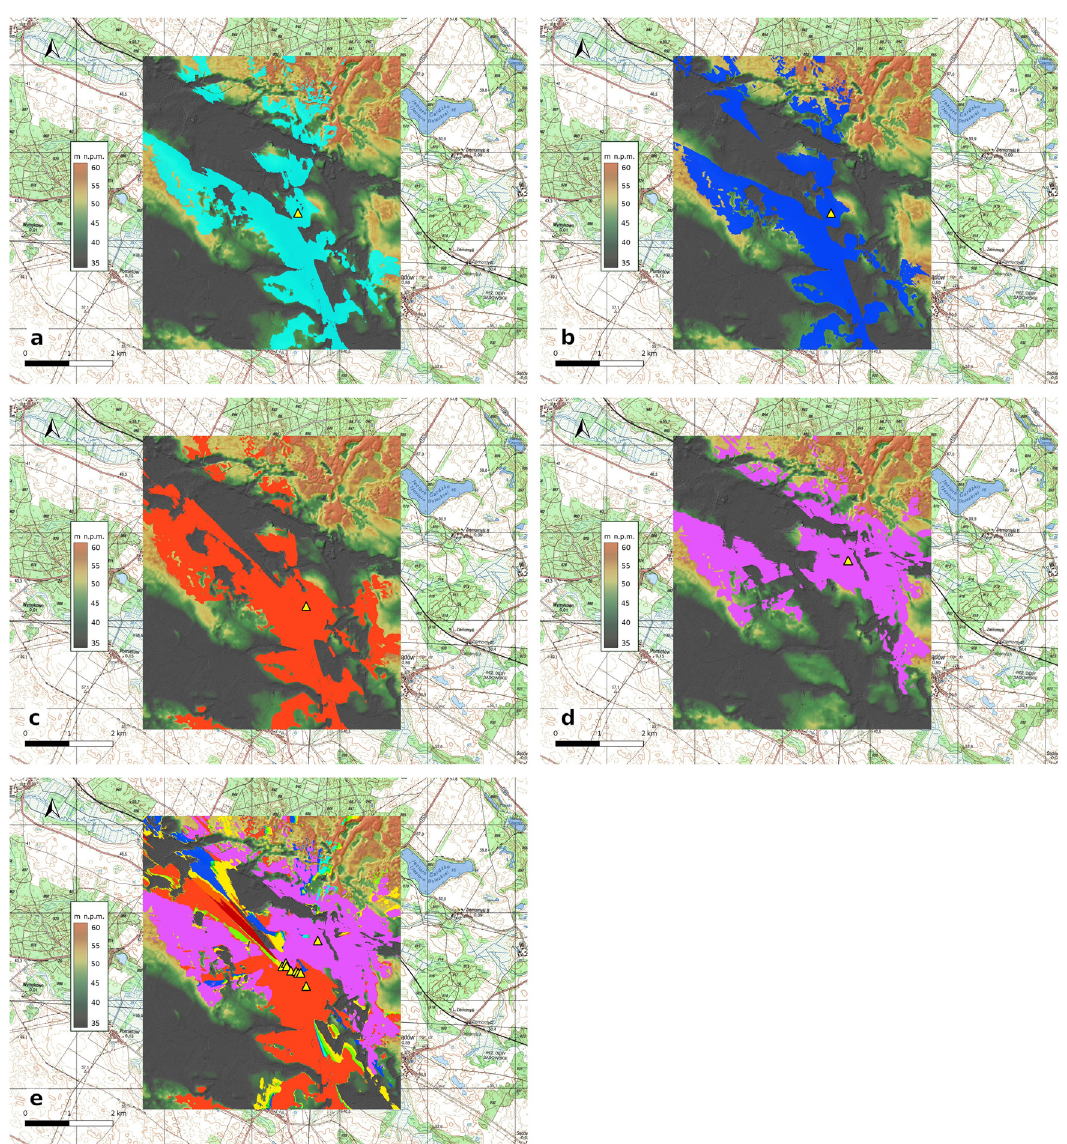
Figure 19: The Dolice - Komorowo South megalithic group. The area from which the tombs 14 ( a ) , 15 ( b ) , 16 ( c ) , and 17 ( d ) are visible and the juxtaposed views ( e ) . ( M. Schiller )